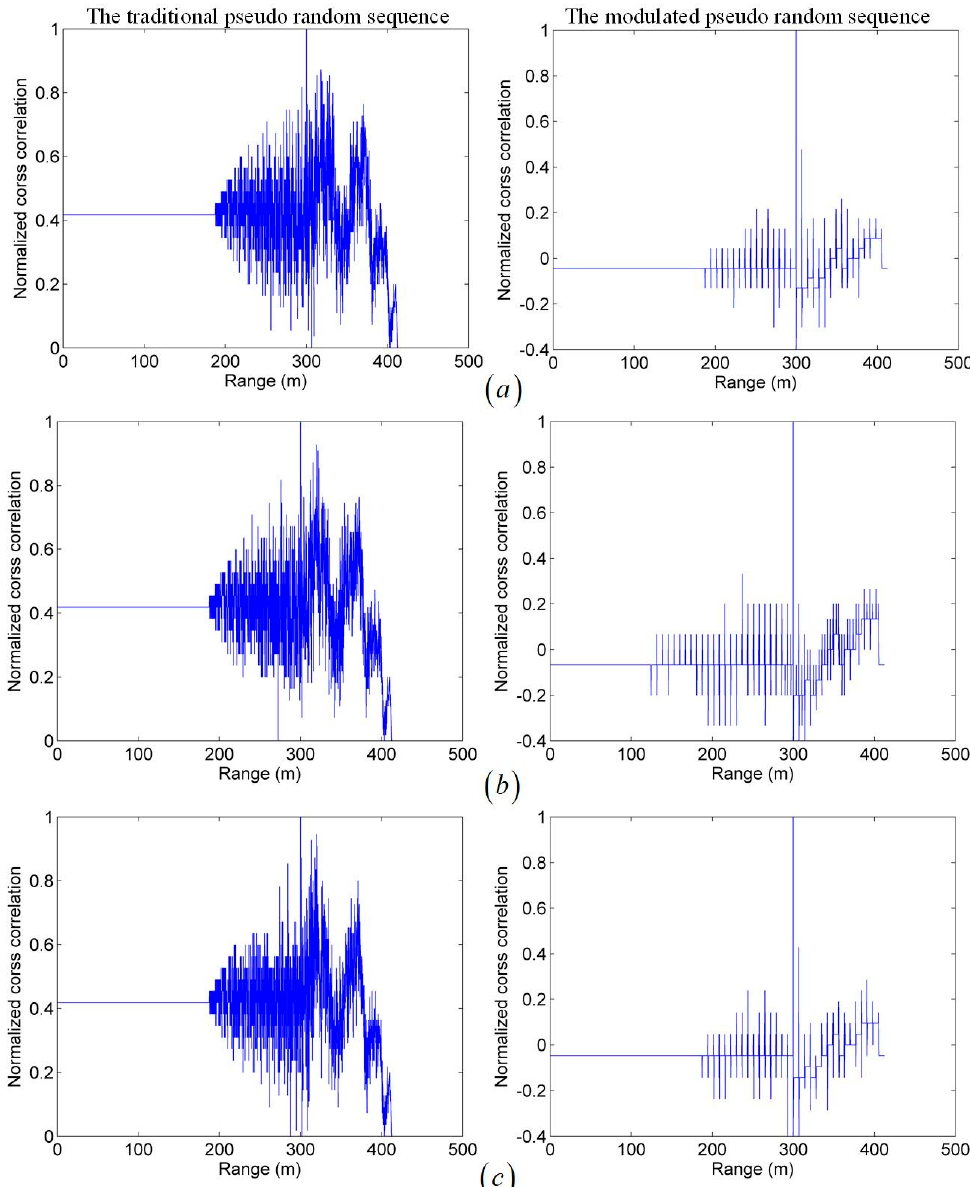
Figure 7. Cross-correlation range images with three different levels of noise photoelectrons. The first column is the Monte Carlo simulation of the traditional pseudo-random sequence, while the second is the modulated pseudo-random sequence. The noise levels of ( a – c ) are represented by the mean number of photoelectron noise. They are 1 × 10 − 4 , 5 × 10 − 4 and 10 × 10 − 4 per bit, respectively.